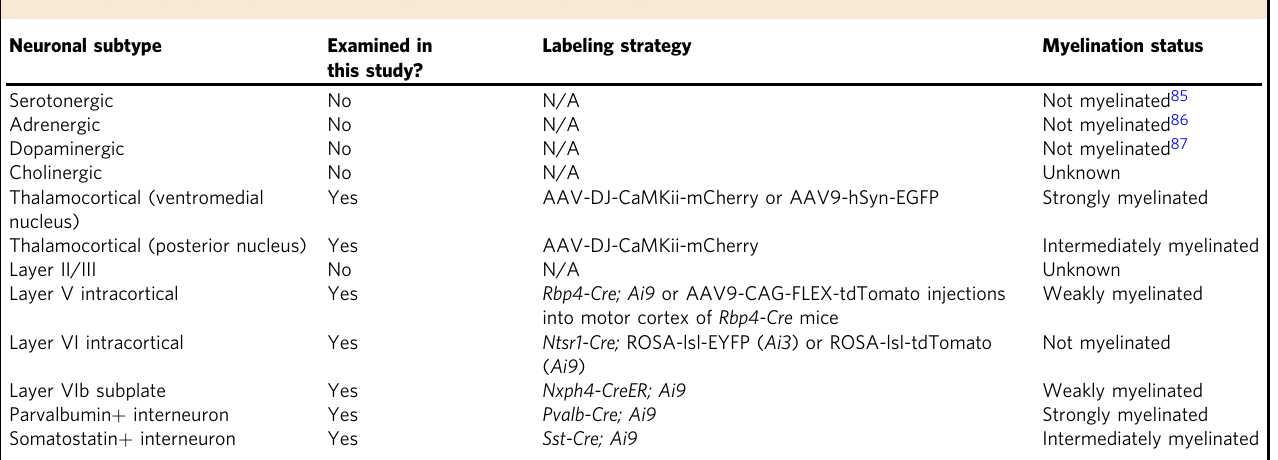
Table 1 Layer I-projecting neuronal subtypes and labeling